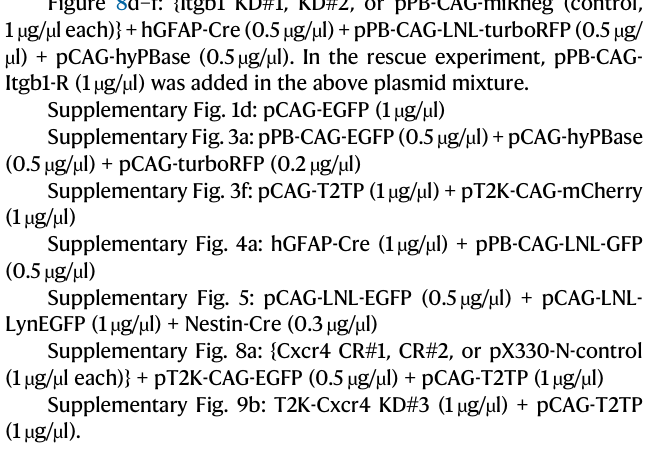
Figure 6d: Cxcr4/7 CR (1 µ g/ µ l) + pPB-CAG-EGFP (0.5 µ g/ µ l) + pCAG-hyPBase (0.5 µ g/ µ l) Figure7a:{Cxcr4 CR#1andCxcr7CR#2(0.5 µ g/ µ leach)}orpX330- N-control (1 µ g/ µ l), + pPB-CAG-EGFP (0.5 µ g/ µ l) + pCAG-hyPBase (0.5 µ g/ µ l) Figure7d:Itgb1KD#1or#2(1 µ g/ µ l)and/orpCAG-Myc-Cxcr4(1 µ g/ µ l) + pCAG-hyPBase (0.5 µ g/ µ l) Figure 8a – c: Cxcr4 CR#2+ Cxcr7 CR#1 (0.5 µ g/ µ l each) or Cxcr4 CR#1 +Cxcr7CR#2(0.5 µ g/ µ leach)orpX330-N-control(1 µ g/ µ l),+pPB- CAG-LNL-EGFP (0.5 µ g/ µ l) + hGFAP-Cre (1 µ g/ µ l) + pCAG-hyPBase (0.5 µ g/ µ l) + pCAG-turboRFP (0.2 µ g/ µ l) Figure 8d – f: {Itgb1 KD#1, KD#2, or pPB-CAG-miRneg (control, 1 µ g/ µ leach)}+hGFAP-Cre(0.5 µ g/ µ l)+pPB-CAG-LNL-turboRFP(0.5 µ g/ µ